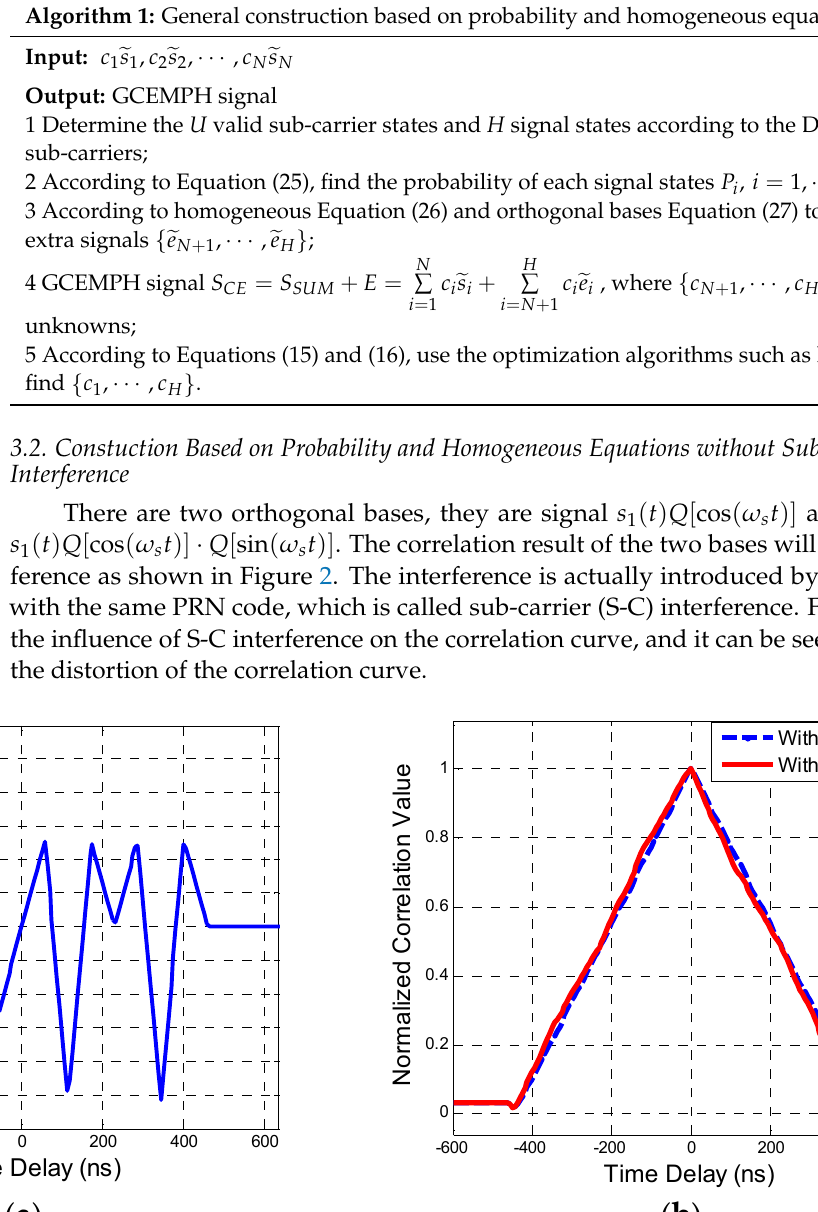
Algorithm 1: General construction based on probability and homogeneous equations